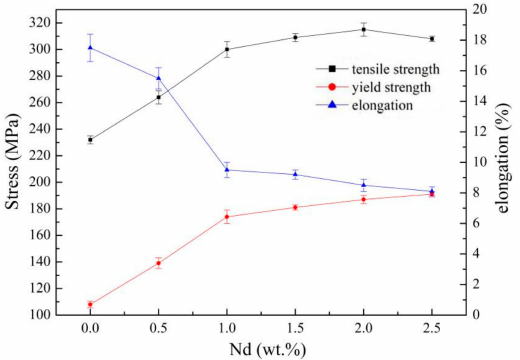
Figure 7. Tensile properties and elongation of the IEECAPed and subsequently aged Mg-xNd-2.0Sm- 0.4Zn-0.4Zr alloys.